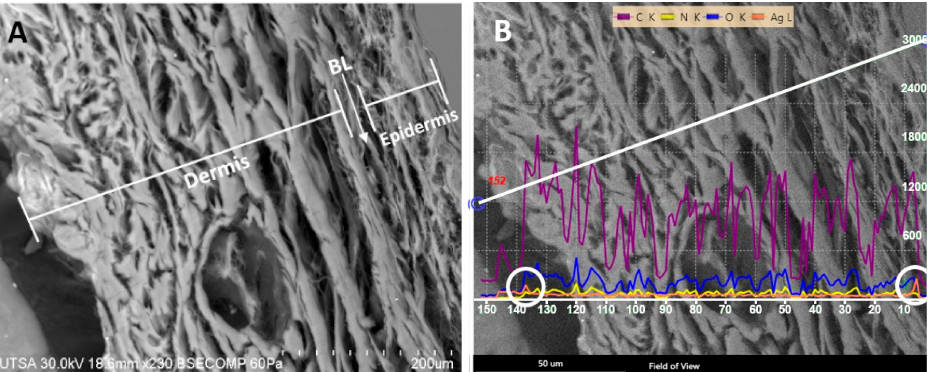
Figure 4. Silver nanoparticles are not retained in the basal lamina. ( A ) SEM image of basal lamina (BL); ( B ) EDS line scan of the basal lamina. The white circles indicate the Ag signal.